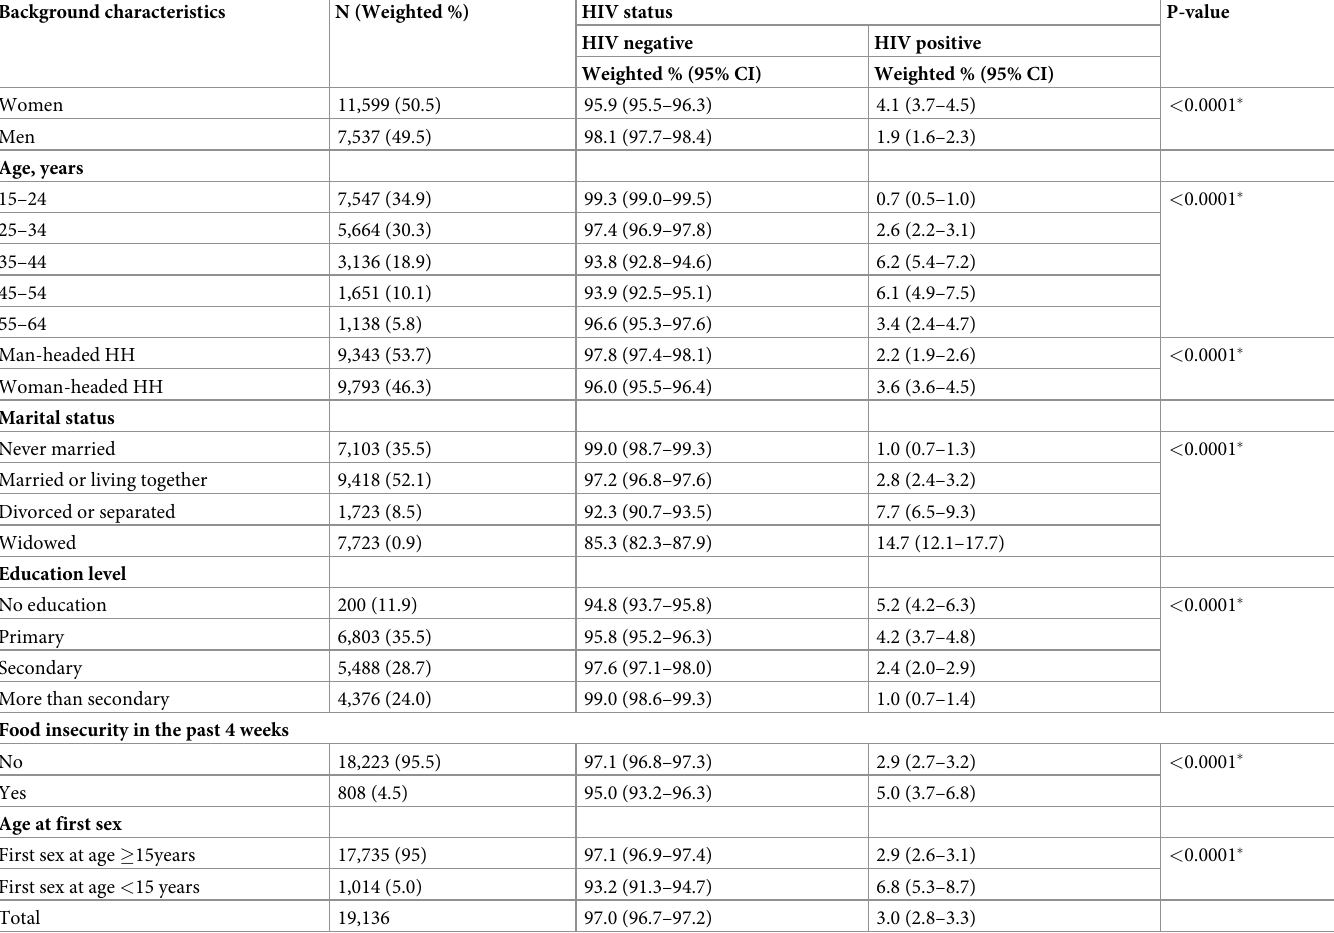
Table 1. Demographic, socioeconomic, and behavioral characteristics of adults aged 15–64 years by HIV status in urban Ethiopia (N = 19,136), Ethiopia Popula- tion-based HIV Impact Assessment Survey (2017–2018). Background